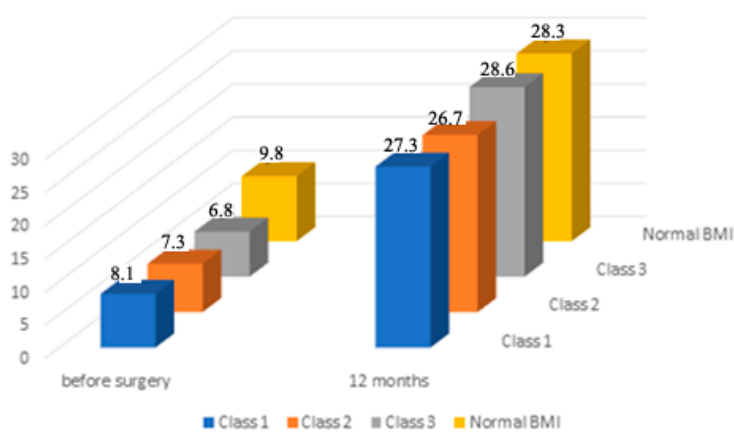
Figure 3. Stage 1—Mental health status before and 12 months after surgery. The total postsurgical complications rate was low in patients with normal BMI (0.15%) and Class 1 obesity (0.25%), with considerably higher and rising rates from the Class 2 up to the Class 3 patients (1.3%, 2.4%, and 4.1% respectively). The rates of postsurgical infections (deep and superficial), prosthesis dislocations, thromboembolic and neurological complications were 2–3 times higher in patients with Class 2 and Class 3 obesity in comparison to patients with Class 1 obesity and normal BMI ( p < 0.05, Table 3). Early